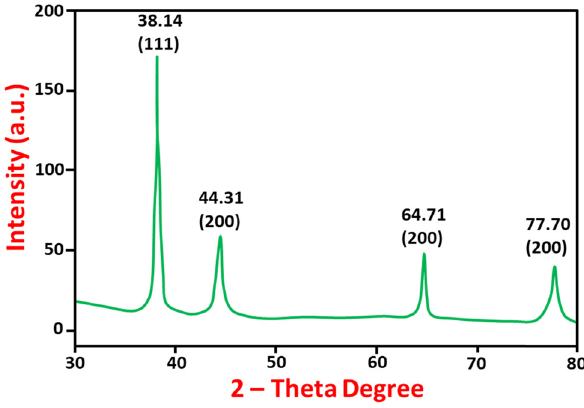
Figure 4: XRD pattern of AuNPs.